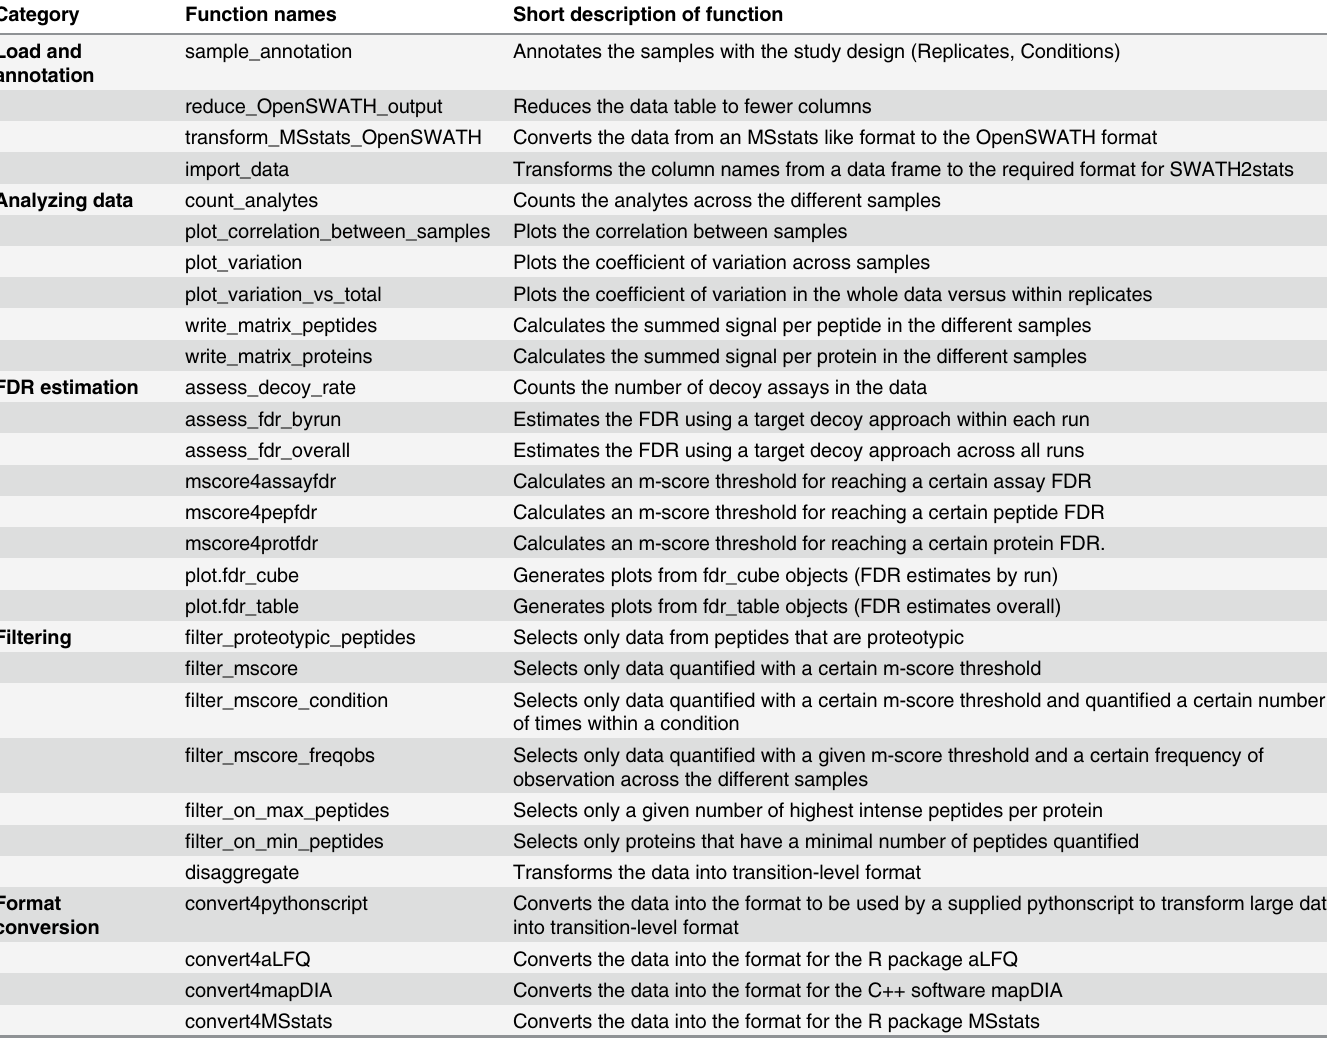
Table 1. Functions included in the SWATH2stats